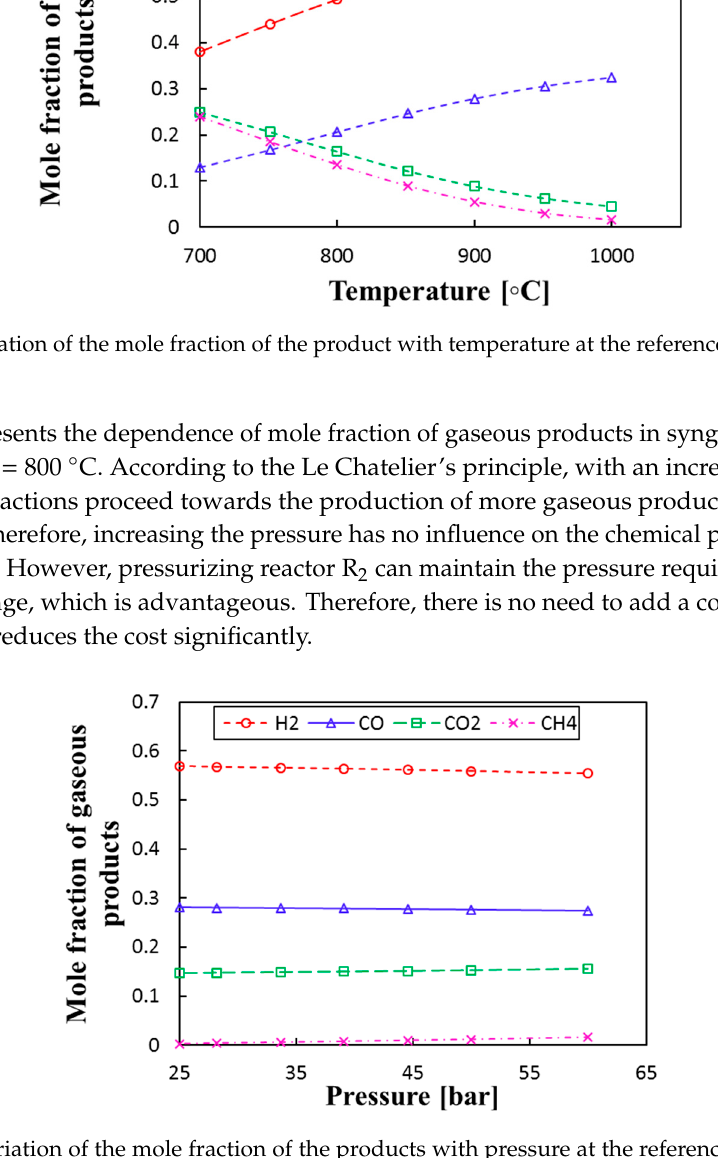
Figure 10. Variation of the mole fraction of the products with pressure at the reference condition in reactor R 2 .